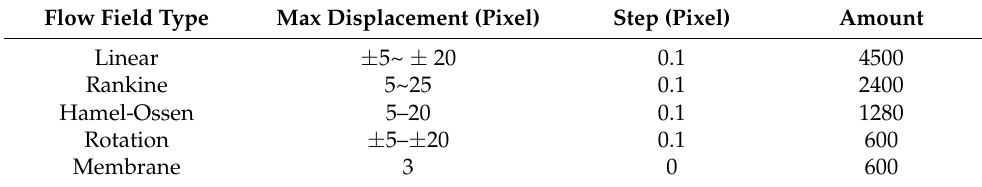
Table 2. Setting of flow field type and maximum displacement parameter range.